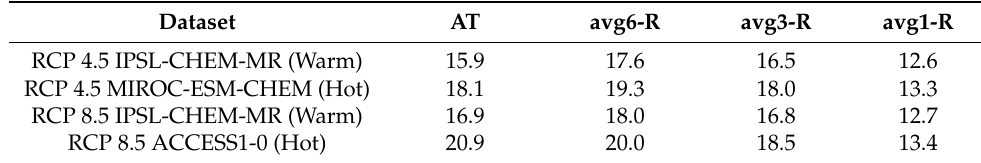
Table 15. Predicted average temperatures for 2048–2053, full dam steady state. Dataset AT avg6-R